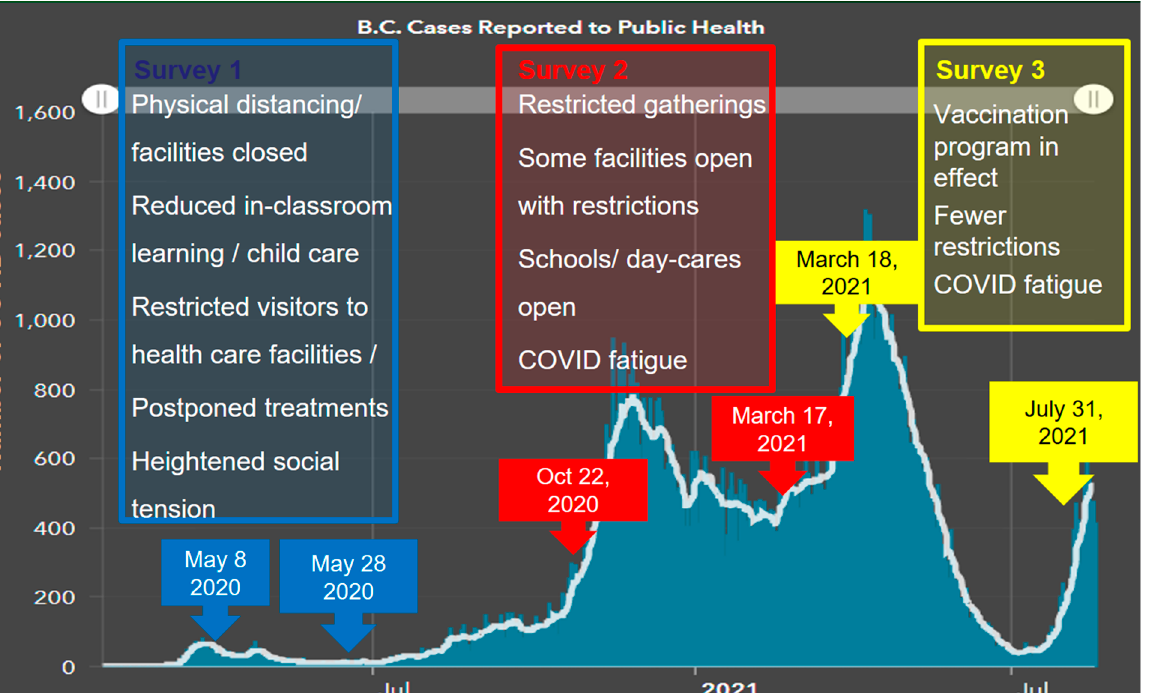
Figure 1. Timeline of surveys superimposed on a graph depicting the waves of COVID-19 cases in BC, Canada as published by BC Centre for Disease Control (https://experience.arcgis.com/experience/a6f23959a8b14bfa989e3cda29297ded). Most relevant public-health measures in effect during each survey period are also summarized [25].